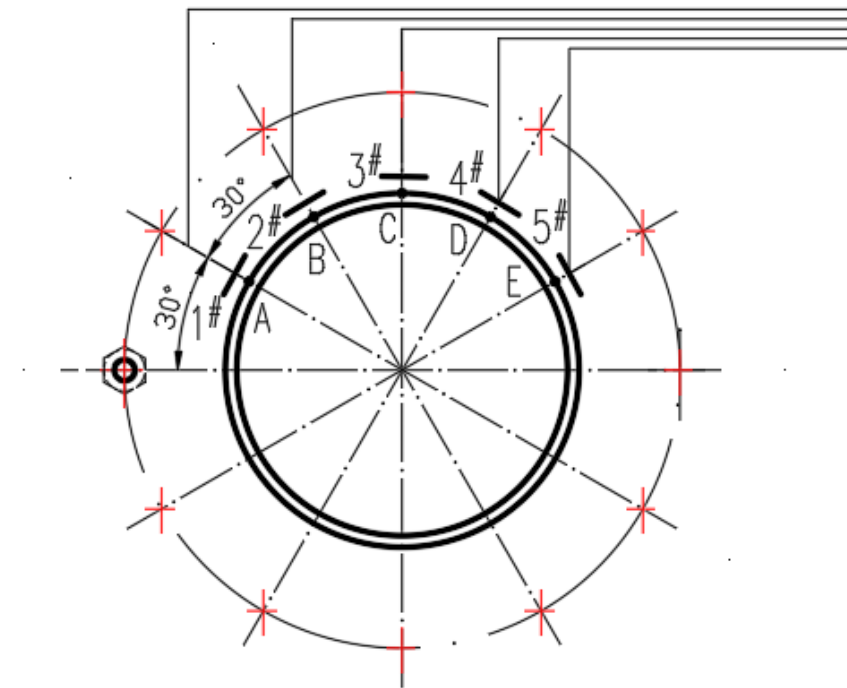
Figure 2. Diagram of the bearing wear testing equipment arrangement.